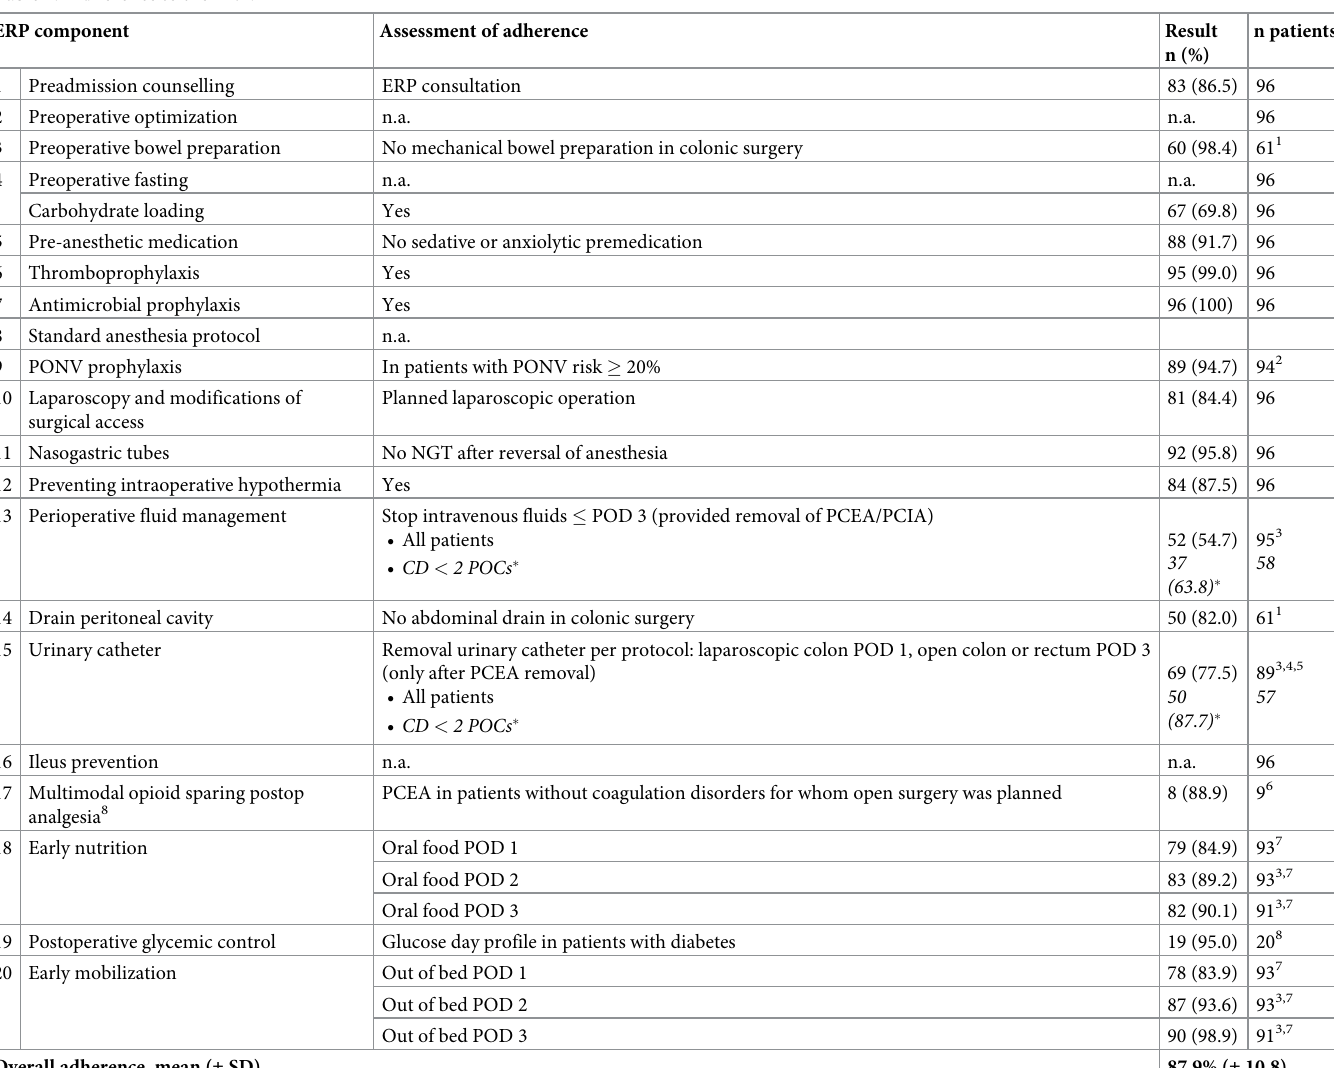
Table 2. Adherence to the